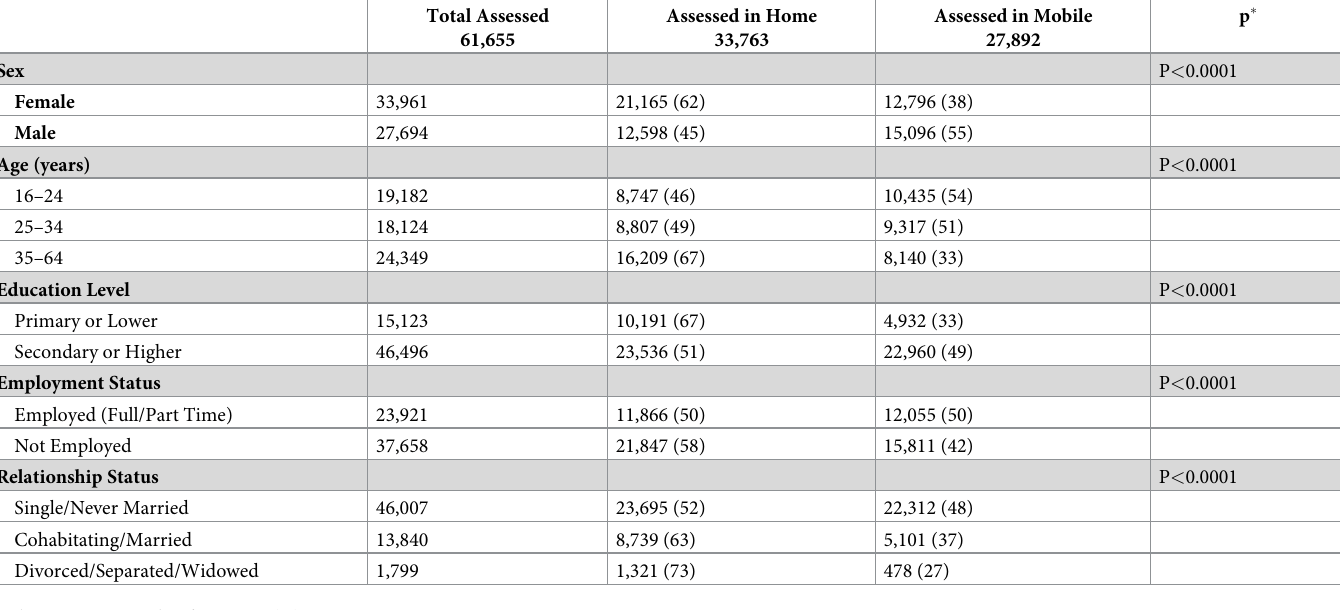
Table 1. Demographic characteristics of persons assessed for HIV in BCPP by HIV testing venue.